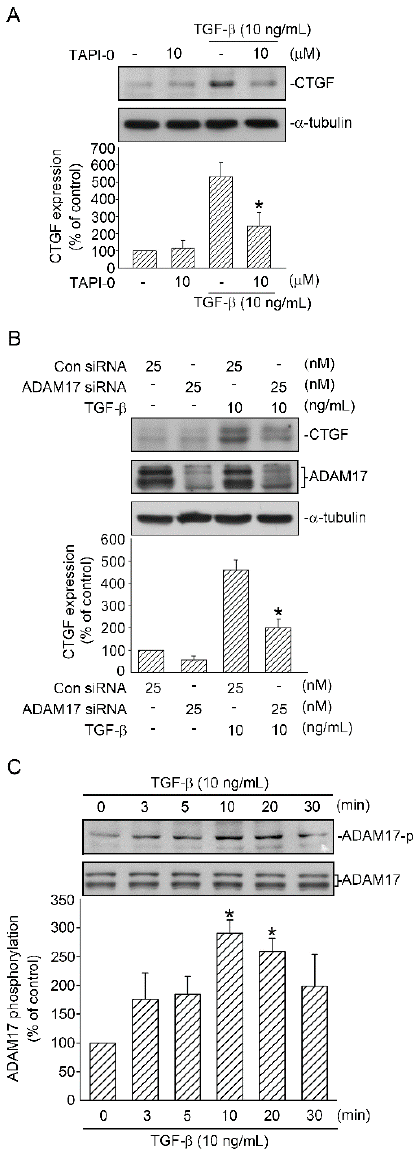
Figure 2. Participation of ADAM17 in TGF- β -induced CTGF expression in human lung epithelial A549 cells. ( A ) A549 cells were processed with the ADAM17 inhibitor TAPI-0 (10 µ M) for 20 min. After 20 min, the cells were stimulated with TGF- β (10 ng / mL) for an additional 6 h. CTGF and α -tubulin levels were detected in cell lysates through Western blotting. Data are expressed as mean ± SEM of three independent experiments. * p < 0.05, compared with the TGF- β group without TAPI-0 treatment. ( B ) A549 cells were transfected with 25 nM control siRNA (con siRNA) and 25 nM ADAM17 siRNA for 48 h before they were stimulated with TGF- β (10 ng / mL) for an additional 6 h. CTGF and α -tubulin levels were detected in cell lysates through Western blotting. Results are expressed as mean ± SEM of three independent experiments. * p < 0.05, compared with TGF- β plus the control siRNA group. ( C ) Cells were stimulated with TGF- β (10 ng / mL) for 0–30 min, and then ADAM17 phosphorylation and ADAM17 were detected in cell lysates through Western blotting. Results are presented as mean ± SEM of four independent experiments. * p < 0.05, compared with the control group without TGF- β treatment. 2.3. Mediating E ff ects of ERK on TGF- β -Induced CTGF Expression and ADAM17 Phosphorylation ERK is a key mediator of several TGF- β -regulated cellular functions [22]. To confirm whether ERK phosphorylation mediates TGF- β -induced CTGF expression, A549 cells were processed with 10 µ